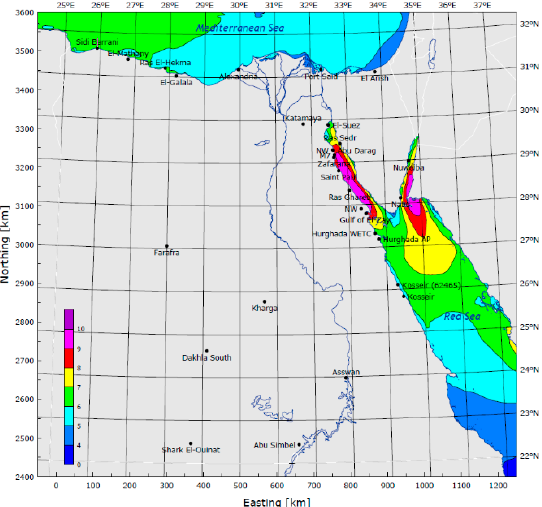
Figure 5. Average wind speed in the Suez Gulf zone from Wind Atlas of Egypt.